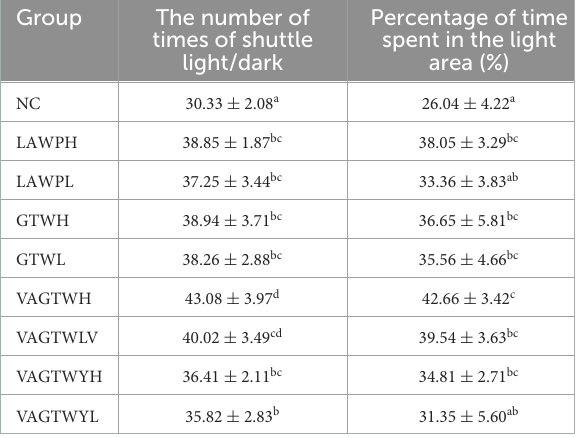
TABLE 2 Effect of Trp peptide on behaviors of zebrafish in the light-dark test ( n = 30). Group The number of times of shuttle